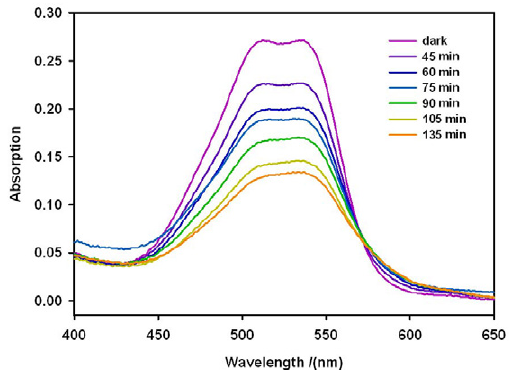
Fig. 8. Calibration curve of Reactive Red 4 and absorption spectra of Reactive Red 4 in defined concentrations.